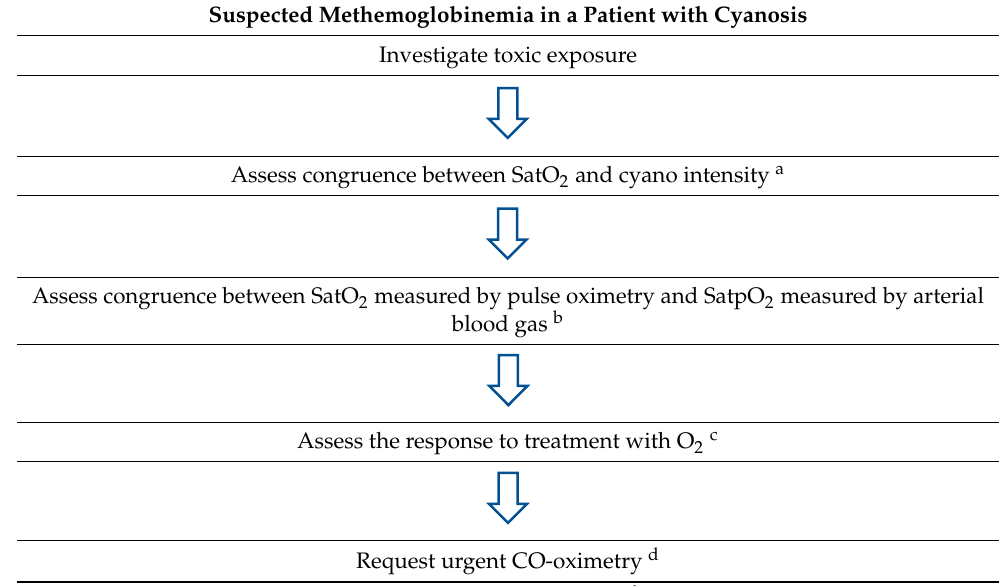
Table 3. Methemoglobinemia. Diagnostic algorithm in the emergency room. Suspected Methemoglobinemia in a Patient with Cyanosis.